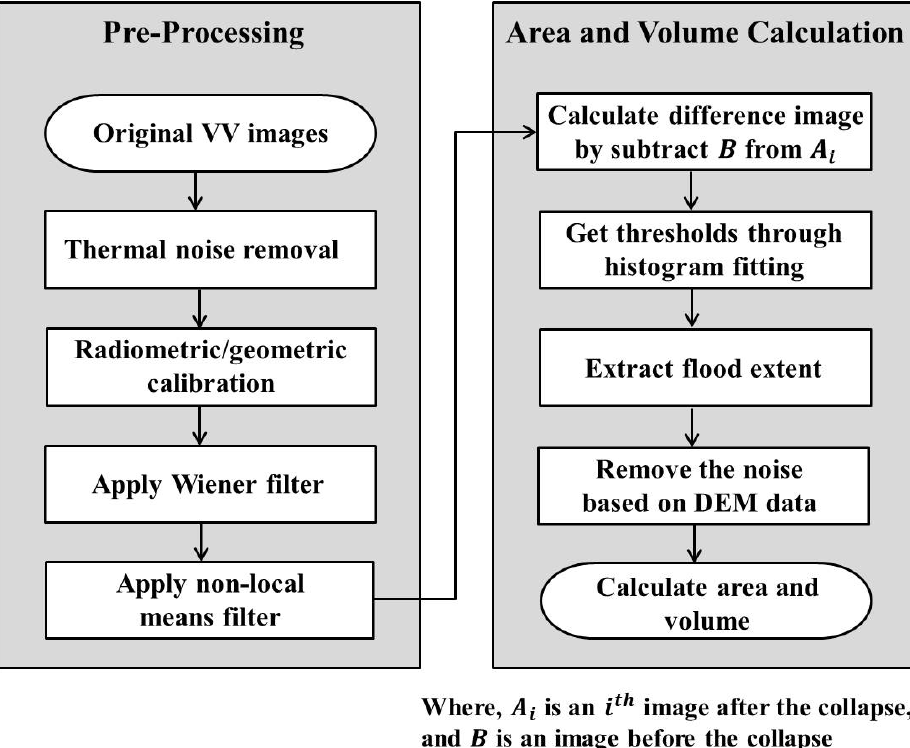
Figure 4. Flowchart for the calculation of flood extent and volume.